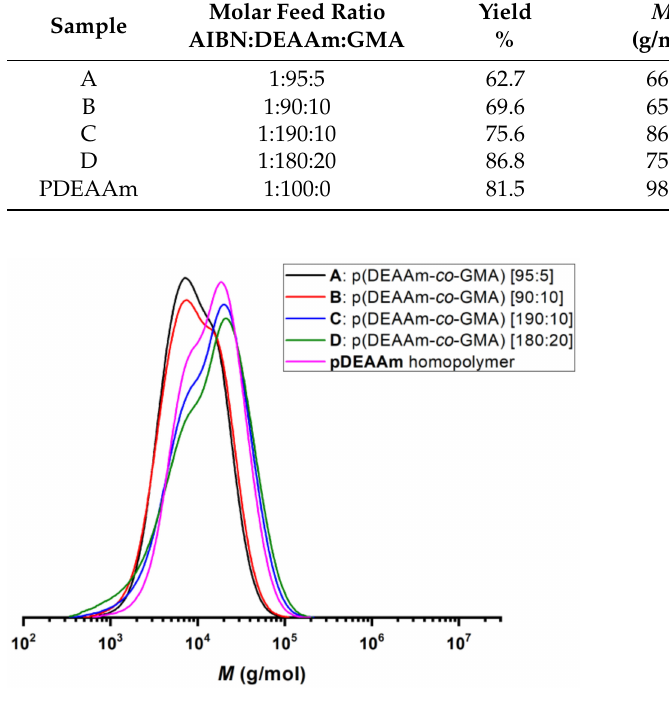
Figure 1. Molar mass distribution curves of the P(DEAAm- co -GMA) copolymers and PDEAAm